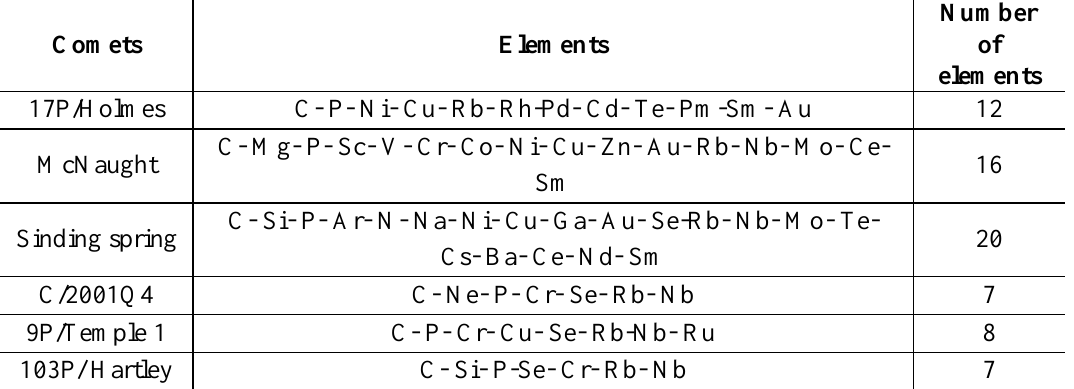
Table 1: Abundance of elements in the studied comets.